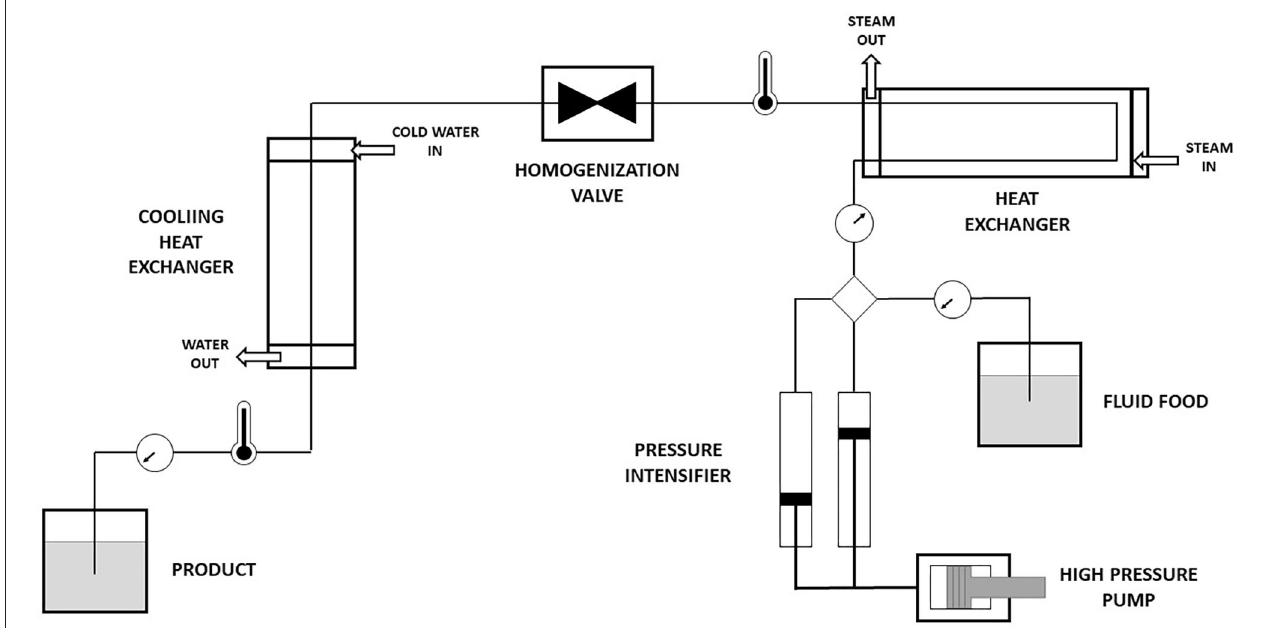
FIGURE 1 | Schematic representation of high-pressure homogenization